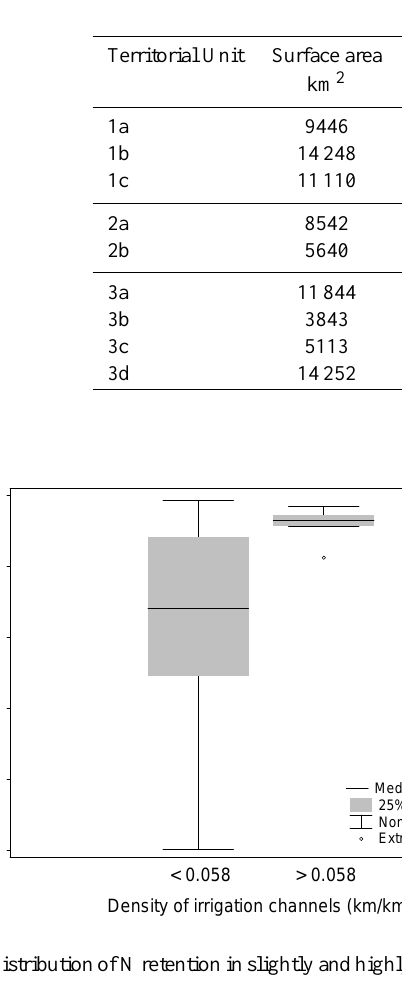
Table 3. Characteristics of the territorial units related to their overall hydrosystem N retention .